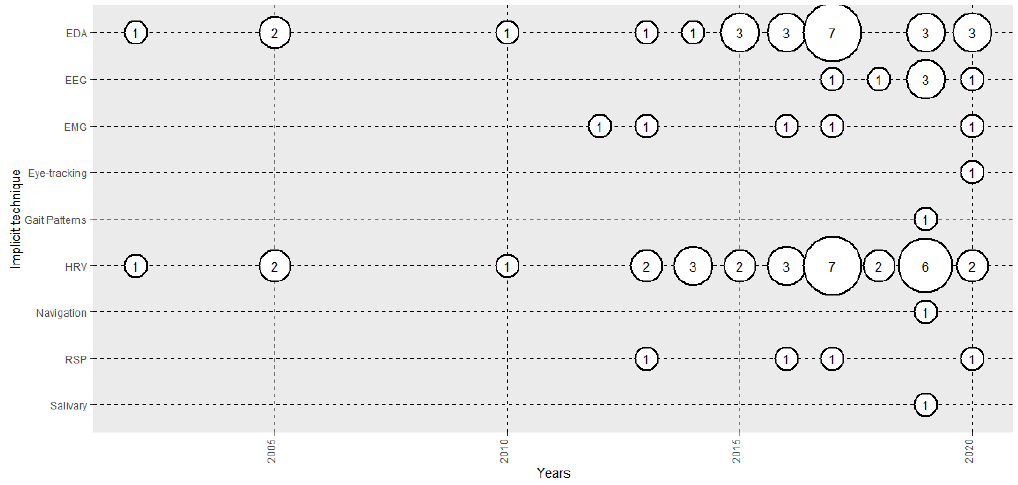
Figure 4. Evolution of the number of papers published each year based on the implicit measure used.